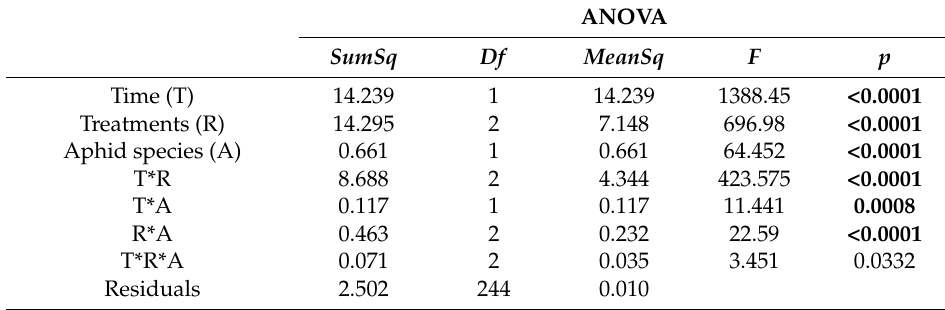
Table 1. Results of ANOVA analysis comparing the overall mortalities over time for each aphid species for the adopted treatments. The interactions between aphid species, treatments and aphid species were also analyzed. Abbreviations: df = degree of freedom, SumSq = sum of squares, MeanSq = mean of squares, F = test value, p = significance level. Values in bold indicate significant differences ( p ≤